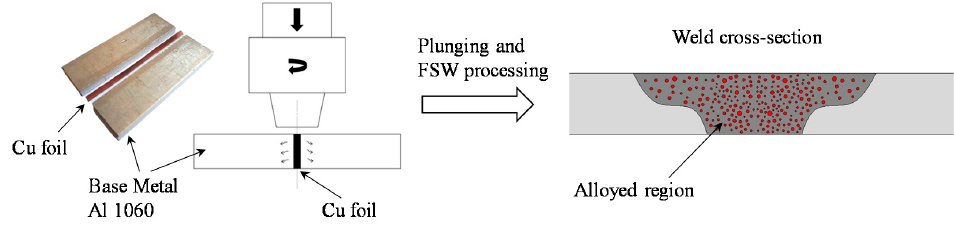
Figure 4. Schematic views of the alloying process through inserting thin copper foils between the faying surfaces of aluminum sheet joints.